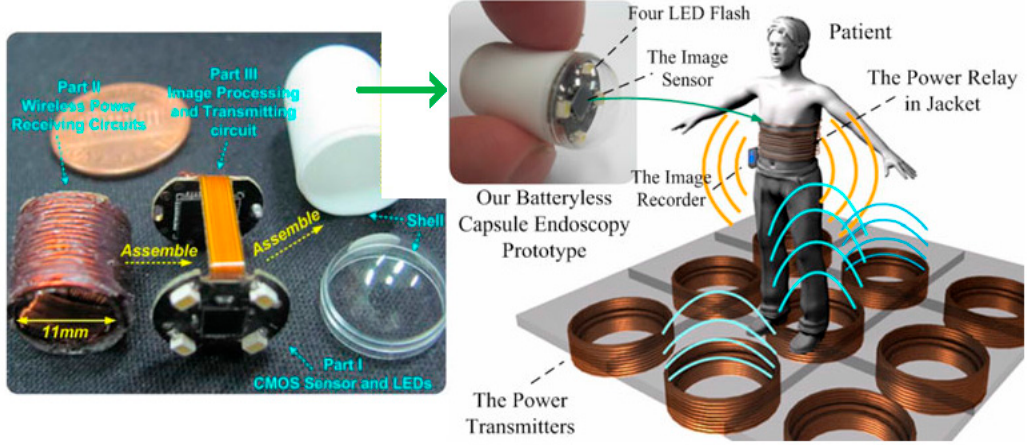
Figure 22. Two-hop NRIC WPT CE system [103]. Copyright © 2012, IEEE.